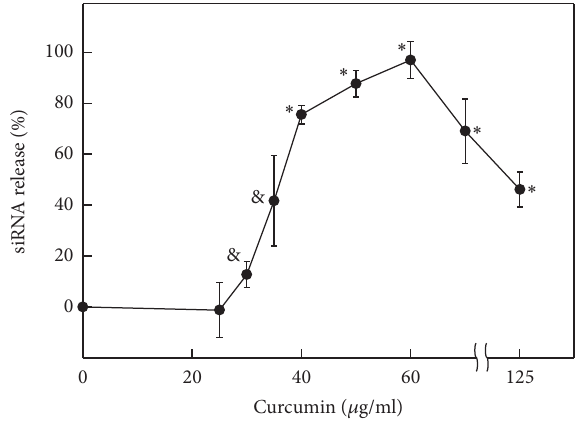
Figure 3: Effect of temperature on the release of siRNA from DOPC/DOPE liposomes induced by curcumin.DOPC/DOPE lipo- somes were treated with curcumin at the indicated concentrations for 30min at room temperature ( e ), 37 ∘ C ( △ ), 50 ∘ C ( ◻ ), and 60 ∘ C ( ◊ ), respectively. Assays were done in triplicate and data were represented as mean values and standard errors (vertical bars). Percentagesof siRNA released were expressed as relative values with Triton X-100-treated samples defined as 100% and DMSO-treated samples as 0%. The results of Student’s 𝑡 -test in comparison of each sample treated with curcumin to control are expressed as 𝑝 values with symbols (&: < 0.05; ∗ : < 0.01) in the figure,